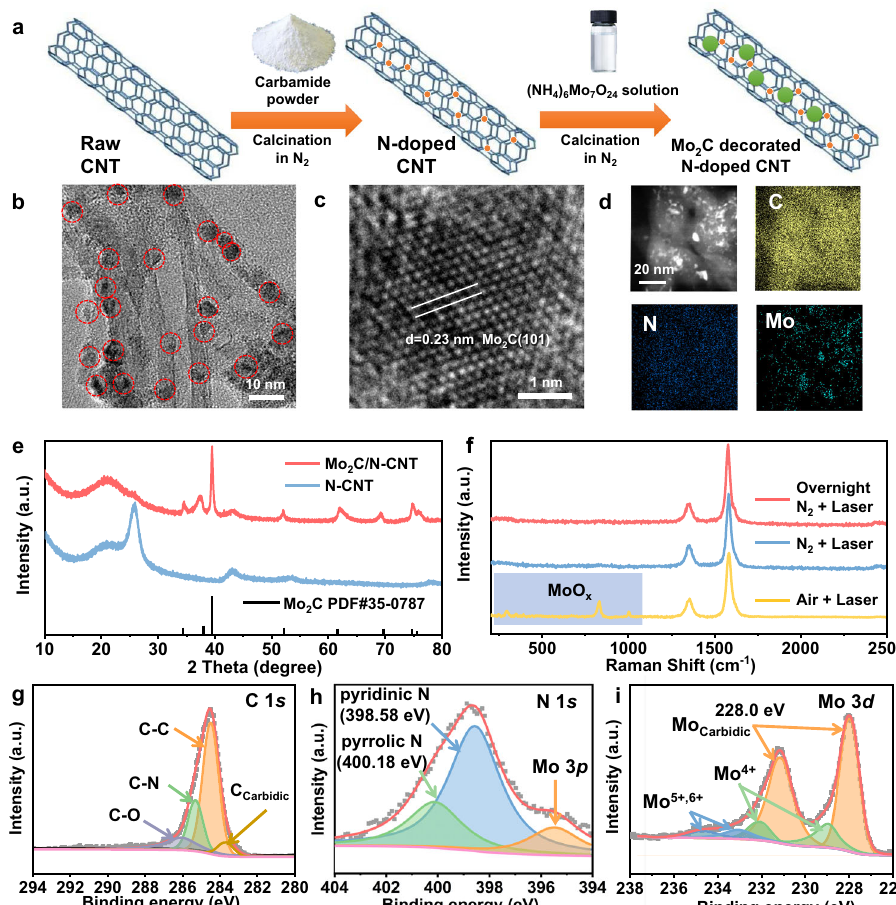
Fig. 1 | Morphologies and chemical states for Mo 2 C/N-CNT. a Schematic illus- tration for the preparation of Mo 2 C/N-CNT. b The TEM and c HRTEM images of Mo 2 C/N-CNT. d The dark- fi eldscanningtransmission electronmicroscopic(STEM) image and the corresponding elemental mapping results of C, N, and Mo of